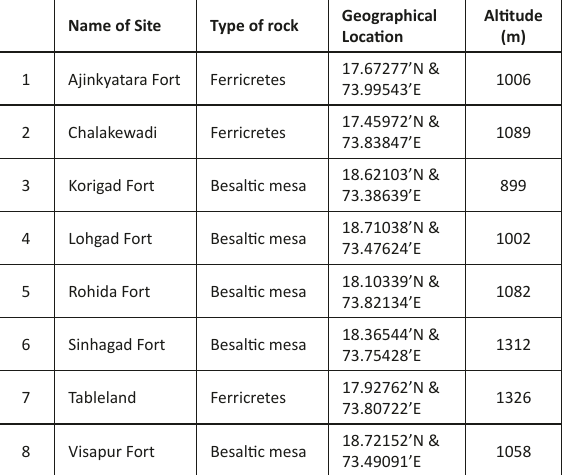
Table 1. Sites for present collection and from available